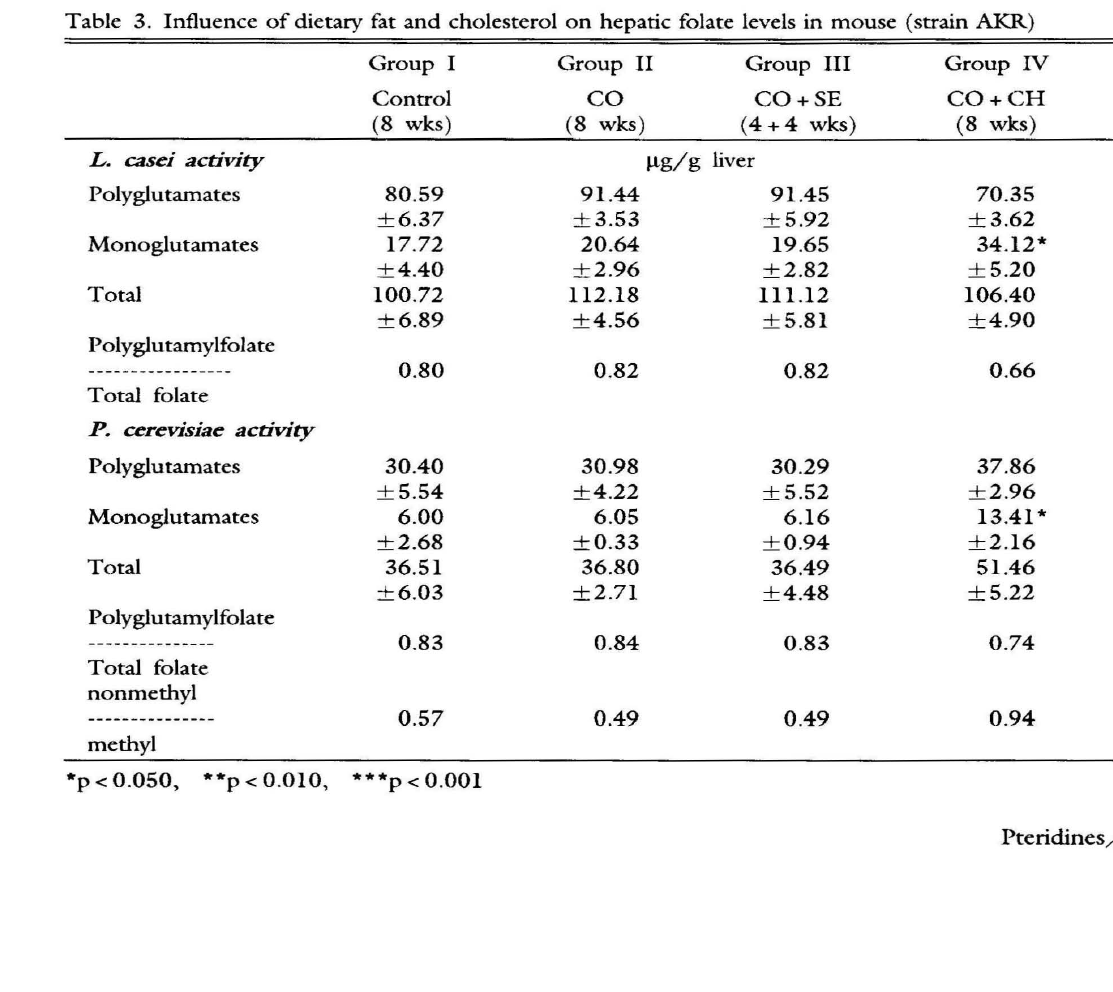
Table 3. Influence of dietary fat and cholesterol on hepatic folate levels in mouse (strain AKR) Group I Group II Group